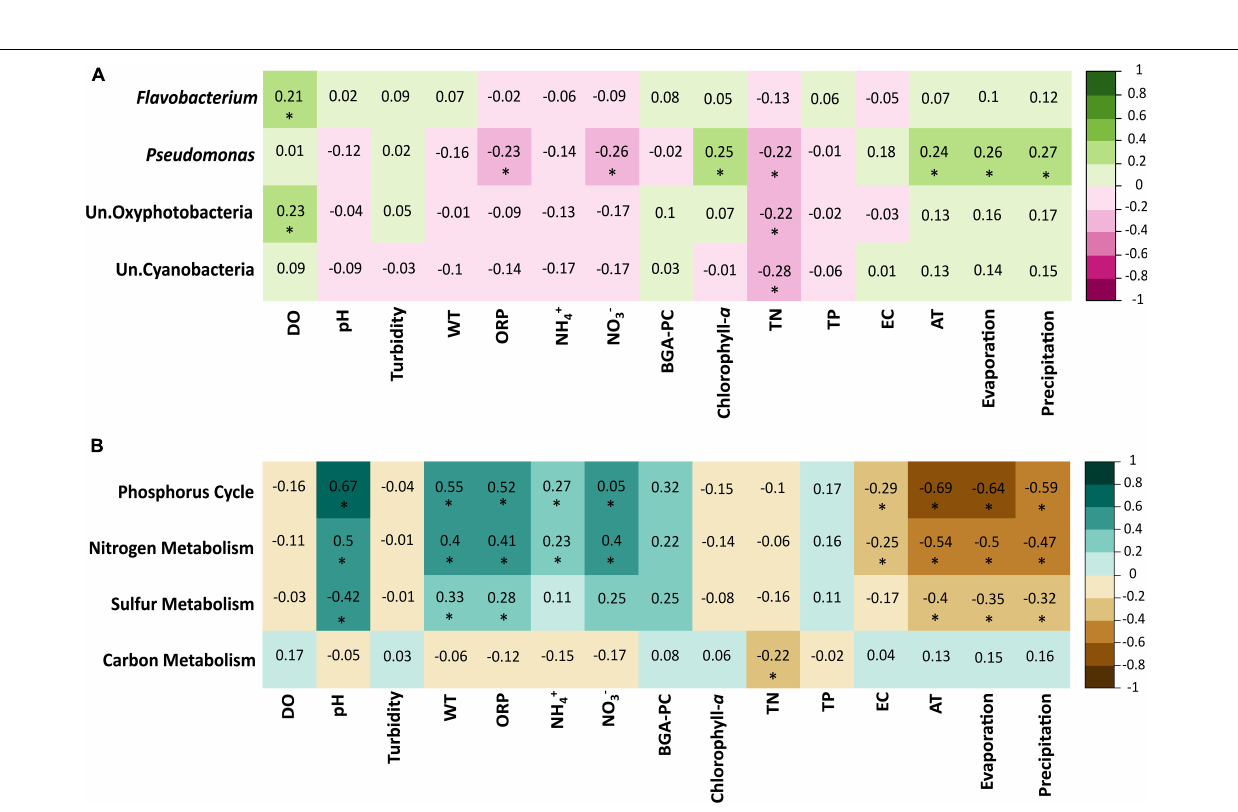
Frontiers in Microbiology |